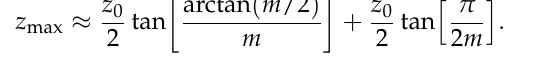
Figure 4. Left and right parts of Equation (29) as functions of z / z 0 at m = 9. On the other hand, the left part of Equation (30) grows slower than the function tan( m ψ ) without the multiplier tan( ψ ). Thus, the first root of Equation (30) should be between the values ψ = m − 1 arctan( m /2) and the discontinuity ψ = π /(2 m ). Thus, the first root of Equation (29) is in the interval from z = z 0 tan[ m –1 arctan( m /2)] to z = z 0 tan( π /(2 m )). In our work, we will use the average